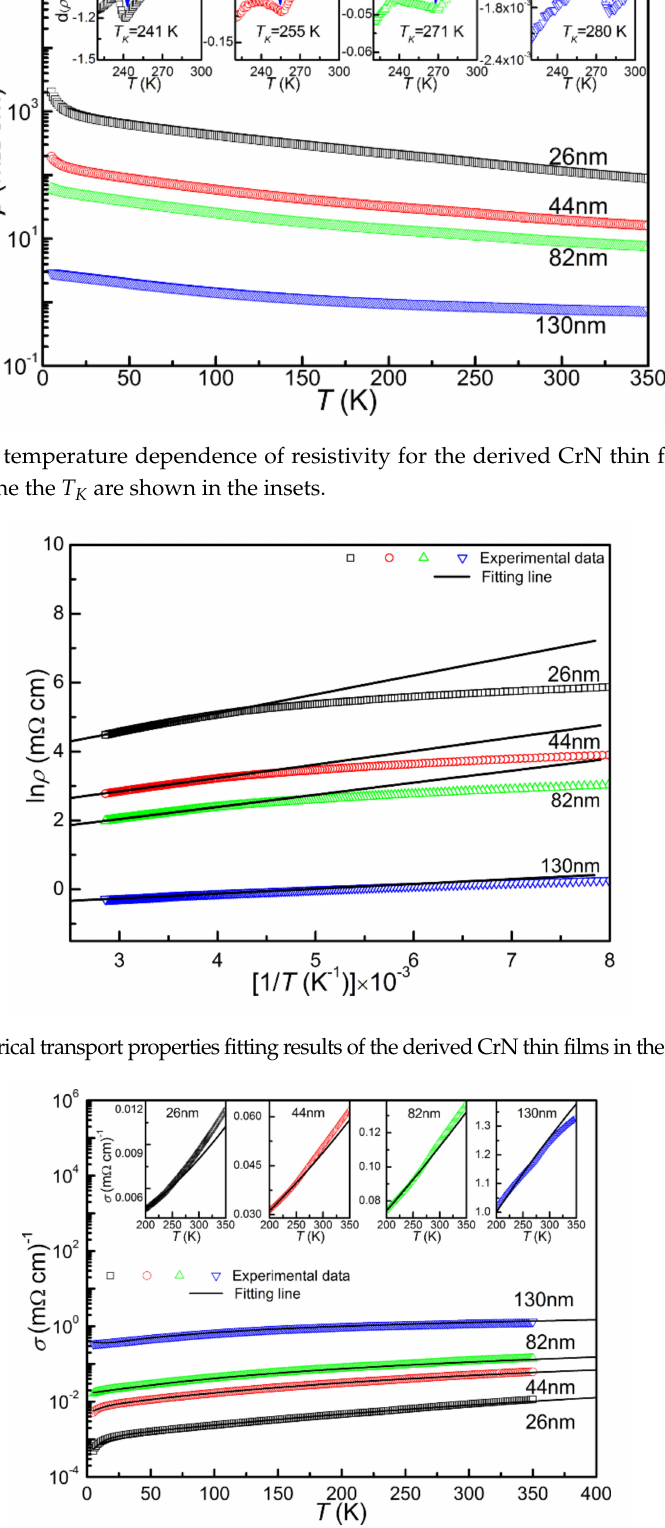
Figure 10. The electrical transport properties fitting results of the derived CrN thin films in the region below T K ; the fitting results with high resolution are shown in the